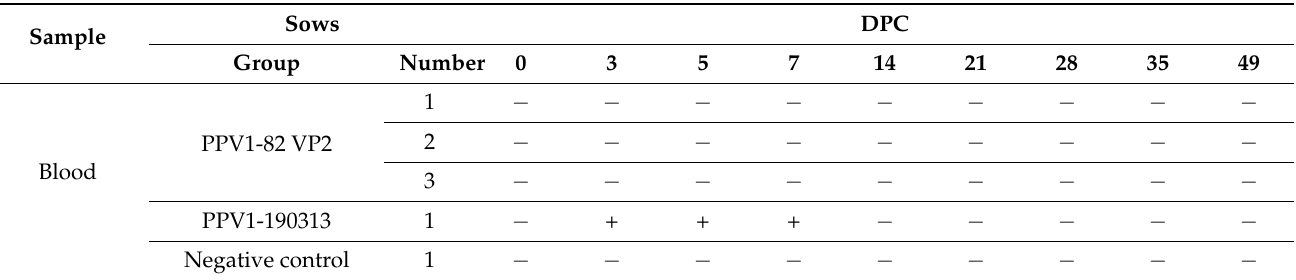
Figure 4. The vaccination and challenge experiment. Sows were intramuscularly vaccinated with the PPV1-82 VP2 antigen (HA value = 2 13 ) combined with the MONTANIDE IMS1313 adjuvant at 50% ( v / v ) at 4 and 2 weeks before conception. At 40 days after conception, vaccinated sows were challenged with 4 mL of the PPV1-190313 strain (at 4.0 × 10 5 TCID 50 /mL); 2 mL was administered by intramuscular injection into the neck, and the other 2 mL was delivered intranasally via a spray. ( A ) Schematic representation of the experimental design. ( B ) Fetuses from vaccinated sows. ( C ) The uterus and fetuses from the unvaccinated PPV1-190313-challenged control sow, which miscarried at 8 DPC. ( D ) Fetuses from the unvaccinated unchallenged negative control sow. Table 3. Detection of PPV1 antigen in sow blood, nasal fluid, and stool samples. The PPV1-82 VP2 vaccinated group (sows 1, 2 and 3) and the PPV1-190313 control sow were challenged at gestation day 40 with the PPV1-190313 strain. Blood, nasal fluid, and stool samples were collected from sows at the indicated days postchallenge (DPC), and conventional PCR was performed to detect PPV1 ; +, PPV1 -positive; − , PPV1